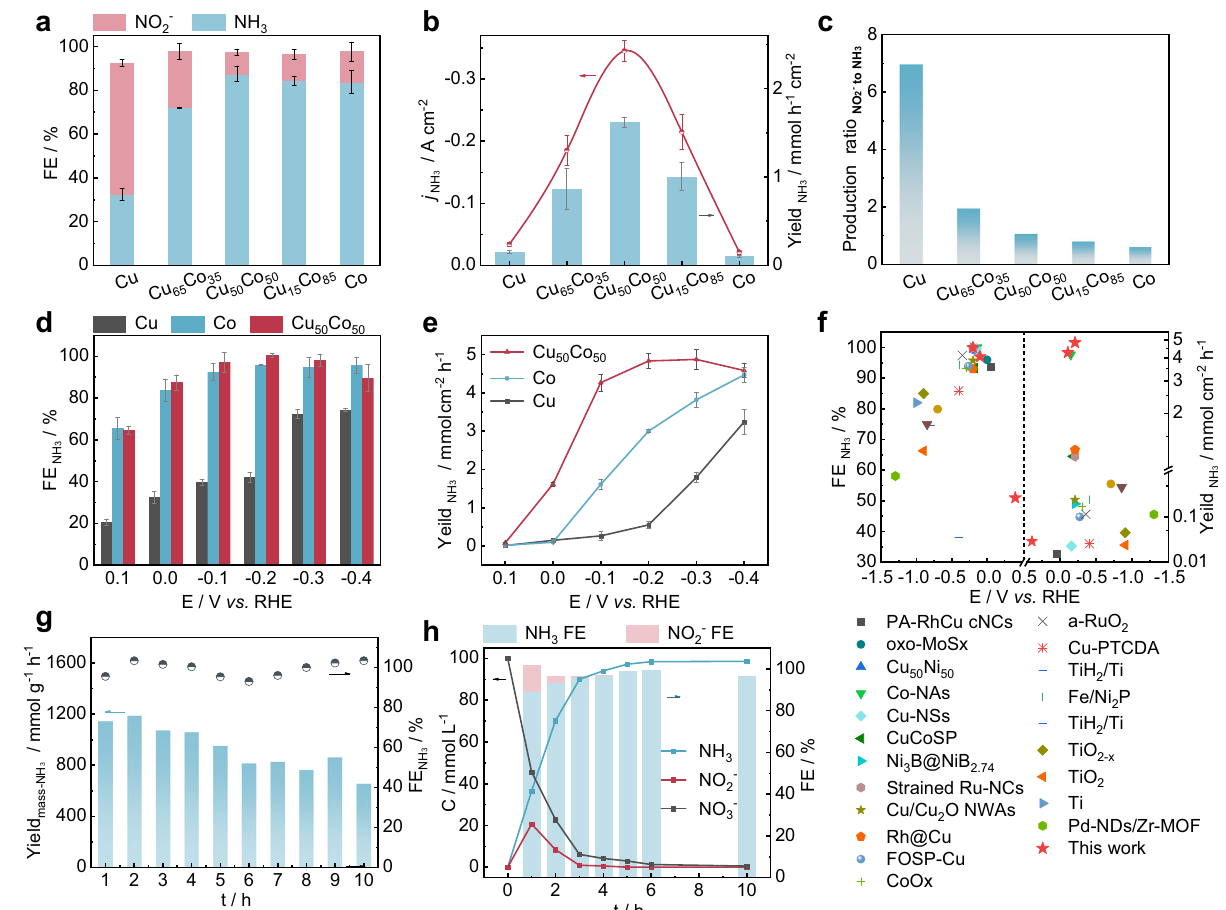
Fig. 3 | Electrochemical performance of catalysts. FENH and FENO (cid:1) of NO 3 − RR and Yieldmass (cid:1) NH on Cu 50 Co 50 /Ni foam under the electrocatalysts ( f ). FENH 3 3 3 2 ( a ),bias-currentdensityandproductsyieldforNH 3 ( b ),andtheratioofNO 2 − toNH 3 applied potential of − 0.2V during 10 periods of 1h electrocatalytic NO 3 - RR ( g ) generated ( c ) for different Cu/Co ratio at 0V in 100mM KNO 3 +1M KOH electro- (catalystsloadingwas5mgcm − 2 ).Thetime-dependentconcentrationofNO 3 − ,NO 2 − ( d ) and NH 3 product yield ( e ) at and NH 3 and corresponding FE over Cu 50 Co 50 modi fi ed Ni foam at − 0.1V ( h ) lyte (catalysts loading was 5mgcm − 2 ). FENH 3 differentelectrodepotentialsonCu 50 Co 50 ,pureCuandpureCocatalystsmodi fi ed (catalysts loading was 5mgcm − 2 ). Error bars represent the standard deviations Ni foam (catalysts loading was5mgcm − 2 ). Comparison of the electrocatalytic NO 3 - calculated from three independent RR performances of Cu 50 Co 50 modi fi ed Ni foam with other extensively reported Fig. S21d), and con fi rmed the reliability of the quanti fi cation methods used in this work. The typical two peaks of 15 NH 4 + after the electrolysis of 15 NO 3 − also suggested that the NH 3 product indeed came from the electrocatalytic reduction of NO 3 − (Supplementary Fig. S21e).